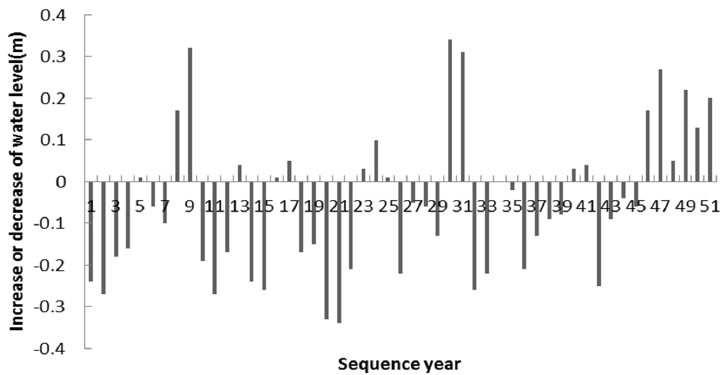
Figure 3. Annual water level changes in Qinghai Lake over 52 years.